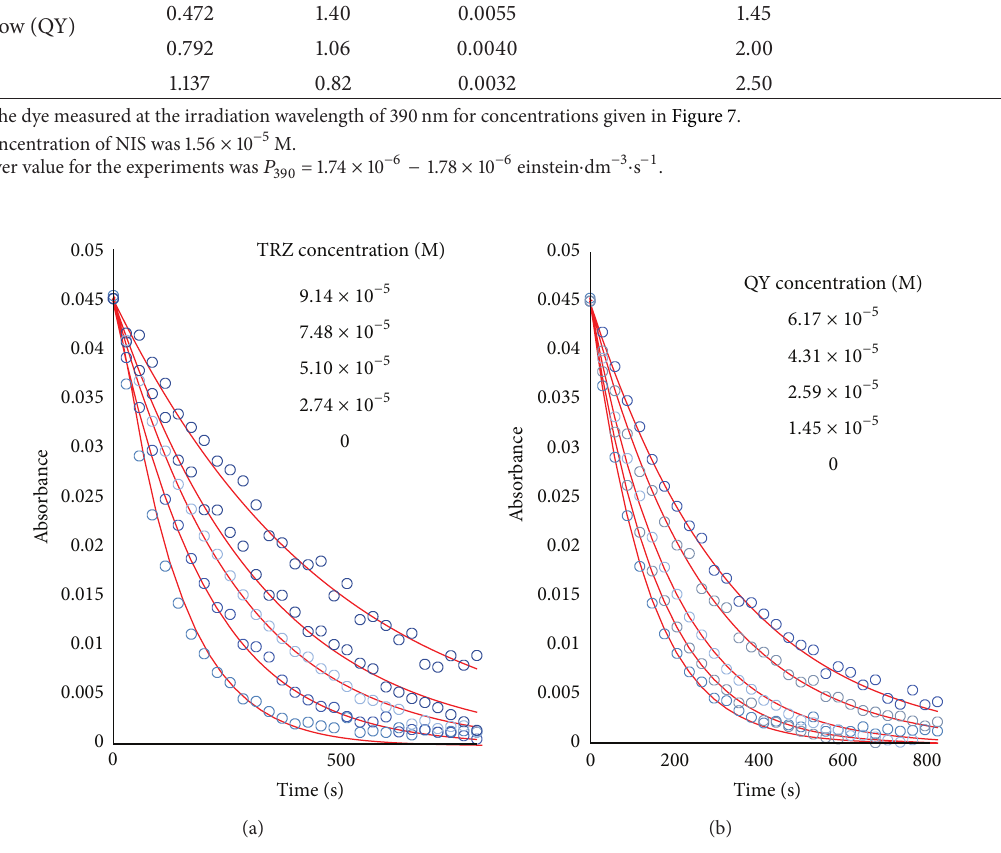
Figure 6: Effect of increasing (a) TRZ and (b) QY concentrations on the photodegradation traces of 1.56 × 10 −5 M NIS solutions when irradiated and observed at 390